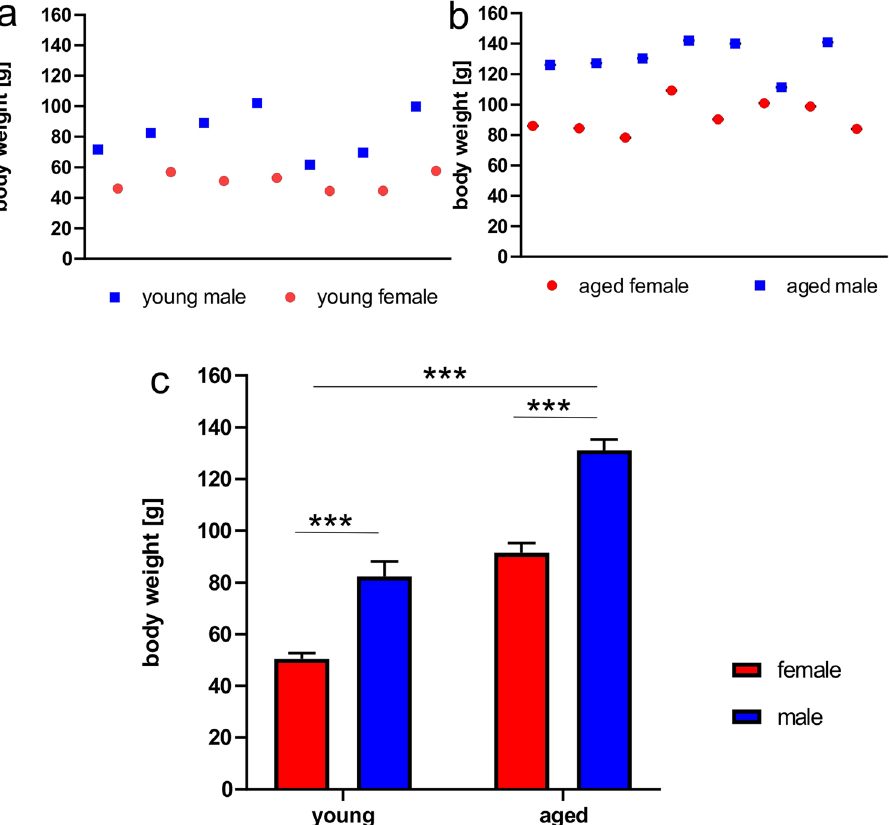
Figure 1. Opossums body weight. Body weight of young females and males ( a ) and aged females and males ( b ). Analysis of body weight measurements in young and aged opossums of both sexes. In ( c ) ***indicates statistical significant difference p <